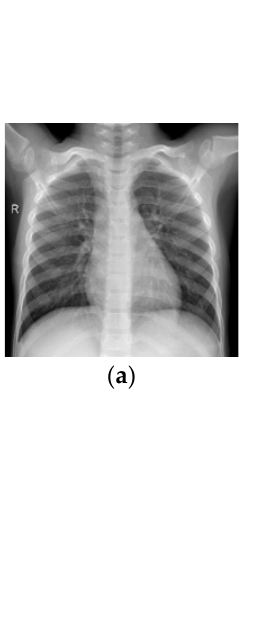
Table 3. The dataset partitions of used dataset [29].